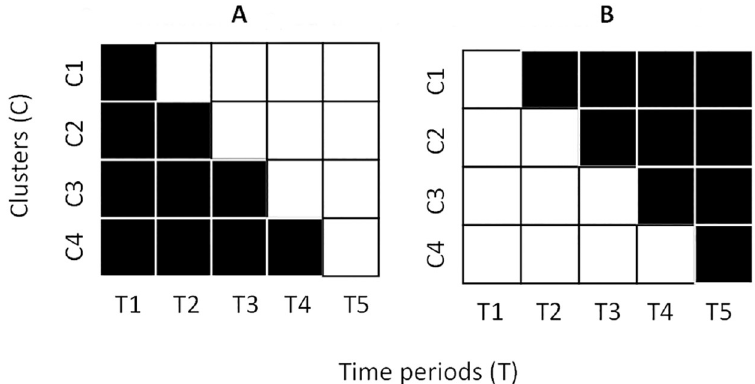
Fig 1. A. Conventional stepped-wedge. B. Disinvestment stepped-wedge. Black = control period. White = intervention period.